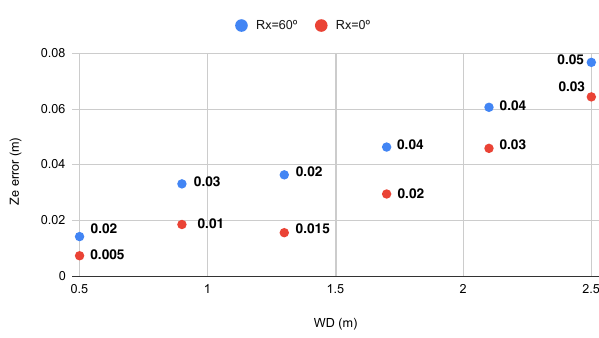
Figure 23. Error and standard deviation in function of the working distance when the target was rotated of R x = 60 ◦ or not rotated R x = 0 ◦ . The points in the chart are the mean values of the error and each point is labelled with the respective value of standard